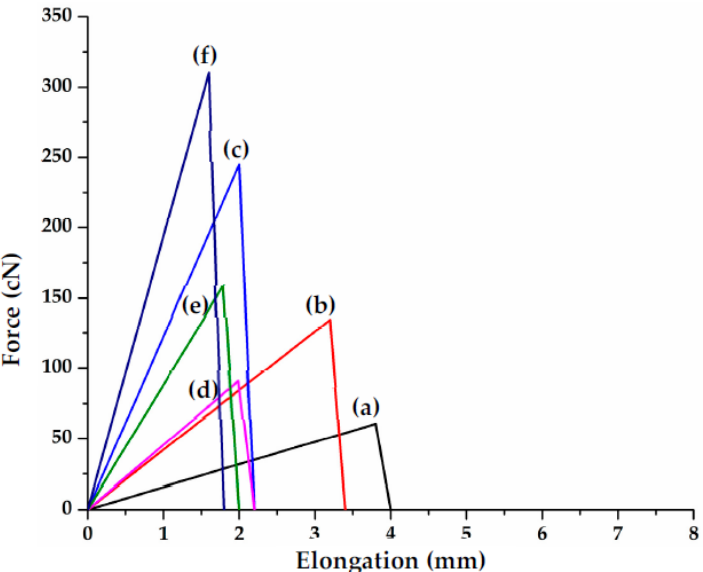
Figure 10. Stress–strain curve of pure alginate hydrogel fibers (( a ): 1%, ( b ): 1.25%, ( c ): 1.5%) and cotton reinforced alginate hydrogel fibers (( d ): 1%, ( e ): 1.25%, ( f ): 1.5%).